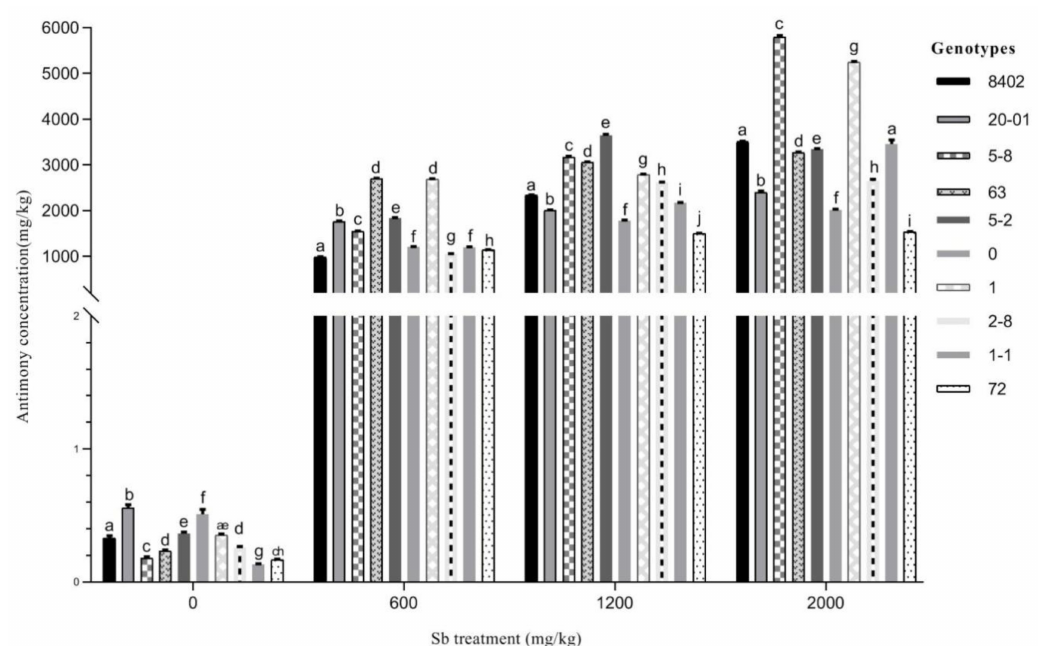
Figure 5. Sb concentrations in roots of Catalpa bungei . Note: Different letters indicate significant differences among the treatments at p < 0.05 ( n =